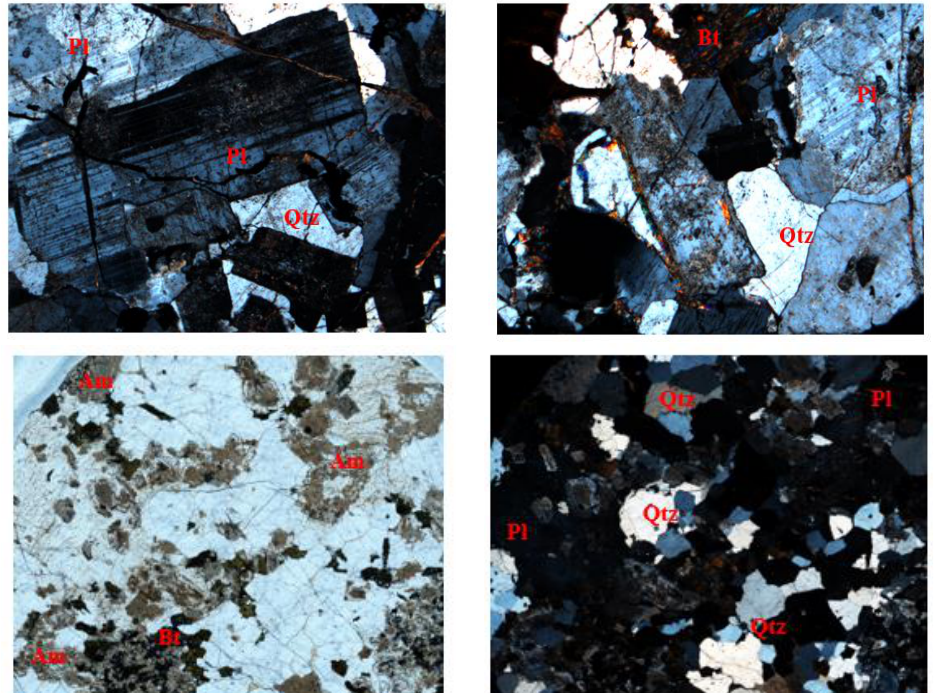
Figure 1. The slice microscopic identification of cores in the YL area of the Qiongdongnan Basin. (Qtz-quartz, Pl-plagioclase, Am-amphibole, Bt-biotite.).